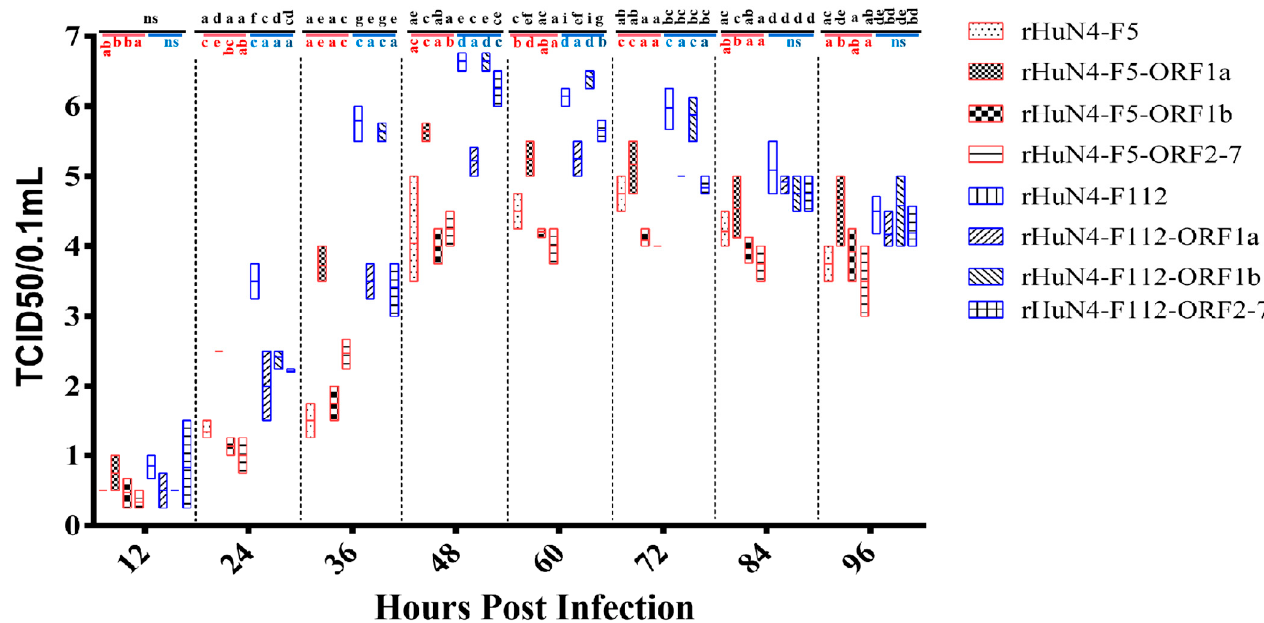
Figure 2. Viral growth kinetics on MARC-145 cells. The growth kinetics of the rescued viruses and their parental virus were determined by assaying the viral titers of the supernatants obtained from 12 to 96 hpi. Chimeric viruses with HuN4 backbone were showed with red border, Chimeric virus with HuN4-F112 backbone were showed with blue border. The results of growth kinetics among all the groups were showed in black alphabets above the black line, the results of rHuN4-F5 and chimeric viruses with rHuN4-F5 backbone were showed in red alphabets below the red line, the results of rHuN4-F5 and chimeric viruses with rHuN4-F5 backbone were showed in blue alphabets below the blue line. Results were showed with single alphabet, or a range of alphabets which were represented by the first and last alphabet. The results which share same alphabet or showed as “ns” means p ≥ 0.05; results do not share same alphabet but have adjacent alphabets with each other means p < 0.05; results do not share same alphabet or adjacent alphabets with each other means p < 0.01. Results among all the viruses were showed with black alphabets above the line, results among HuN4-F5 backbone chimeric viruses were showed with red alphabets below the line, and results among HuN4-F112 backbone chimeric viruses were showed with light blue alphabets below the line.